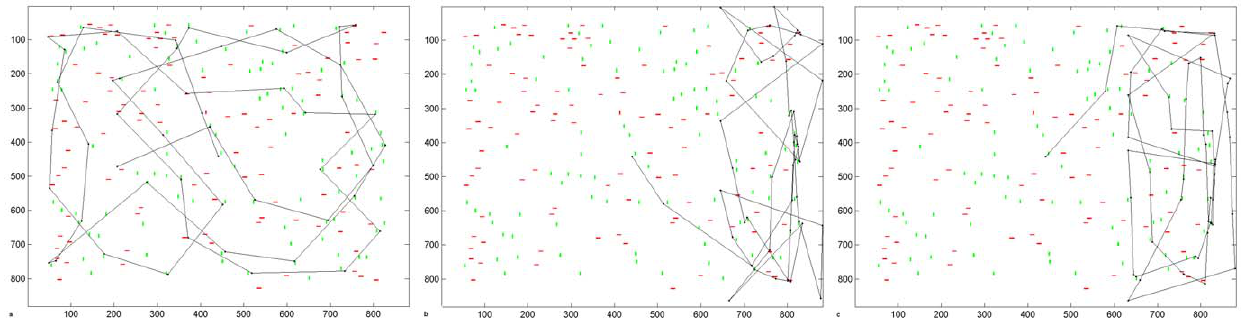
Figure 3. Visual Search Scanpaths Produced by the Model. Simulated scanpaths under (a) normal conditions, (b) hemianopic V1 lesion, and (c) hemineglect parietal lesion. No compensatory mechanism has yet been learned; the weight of the compensation bias is zero and the lateral connections in the extrastriate module are not yet present. Axes refer to pixel position in the scene.